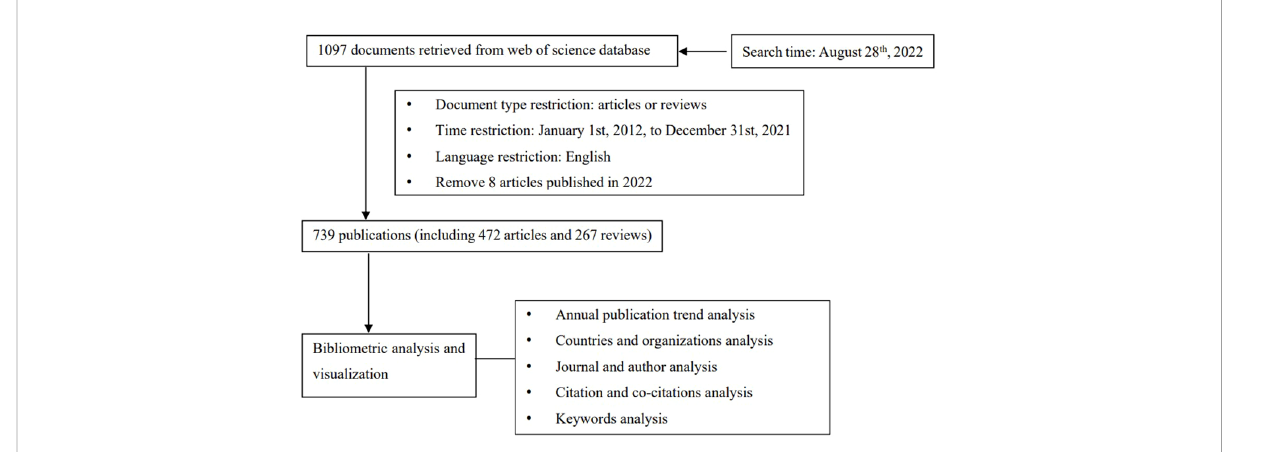
FIGURE 1 Flowchart of data collection and